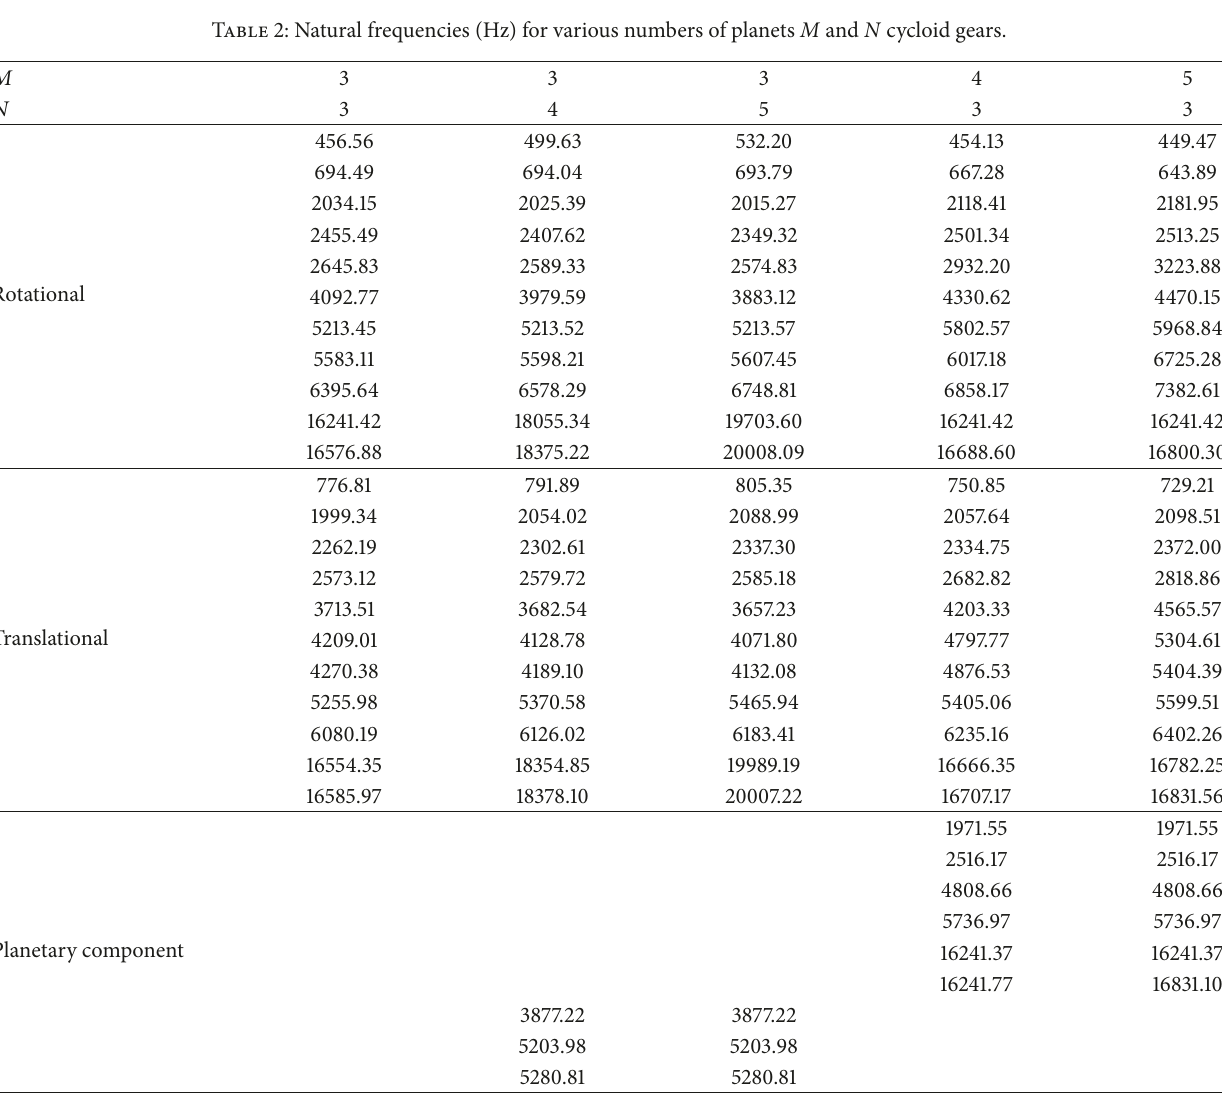
Table 2: Natural frequencies (Hz) for various numbers of planets M and N cycloid